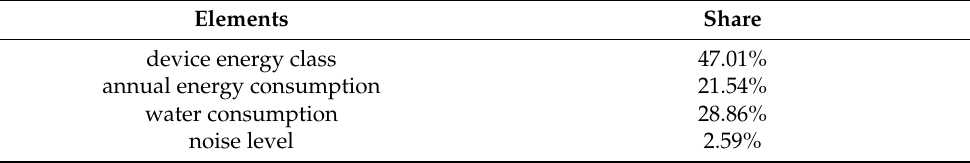
Table 4. Elements taken into account by respondents when reading energy labels.